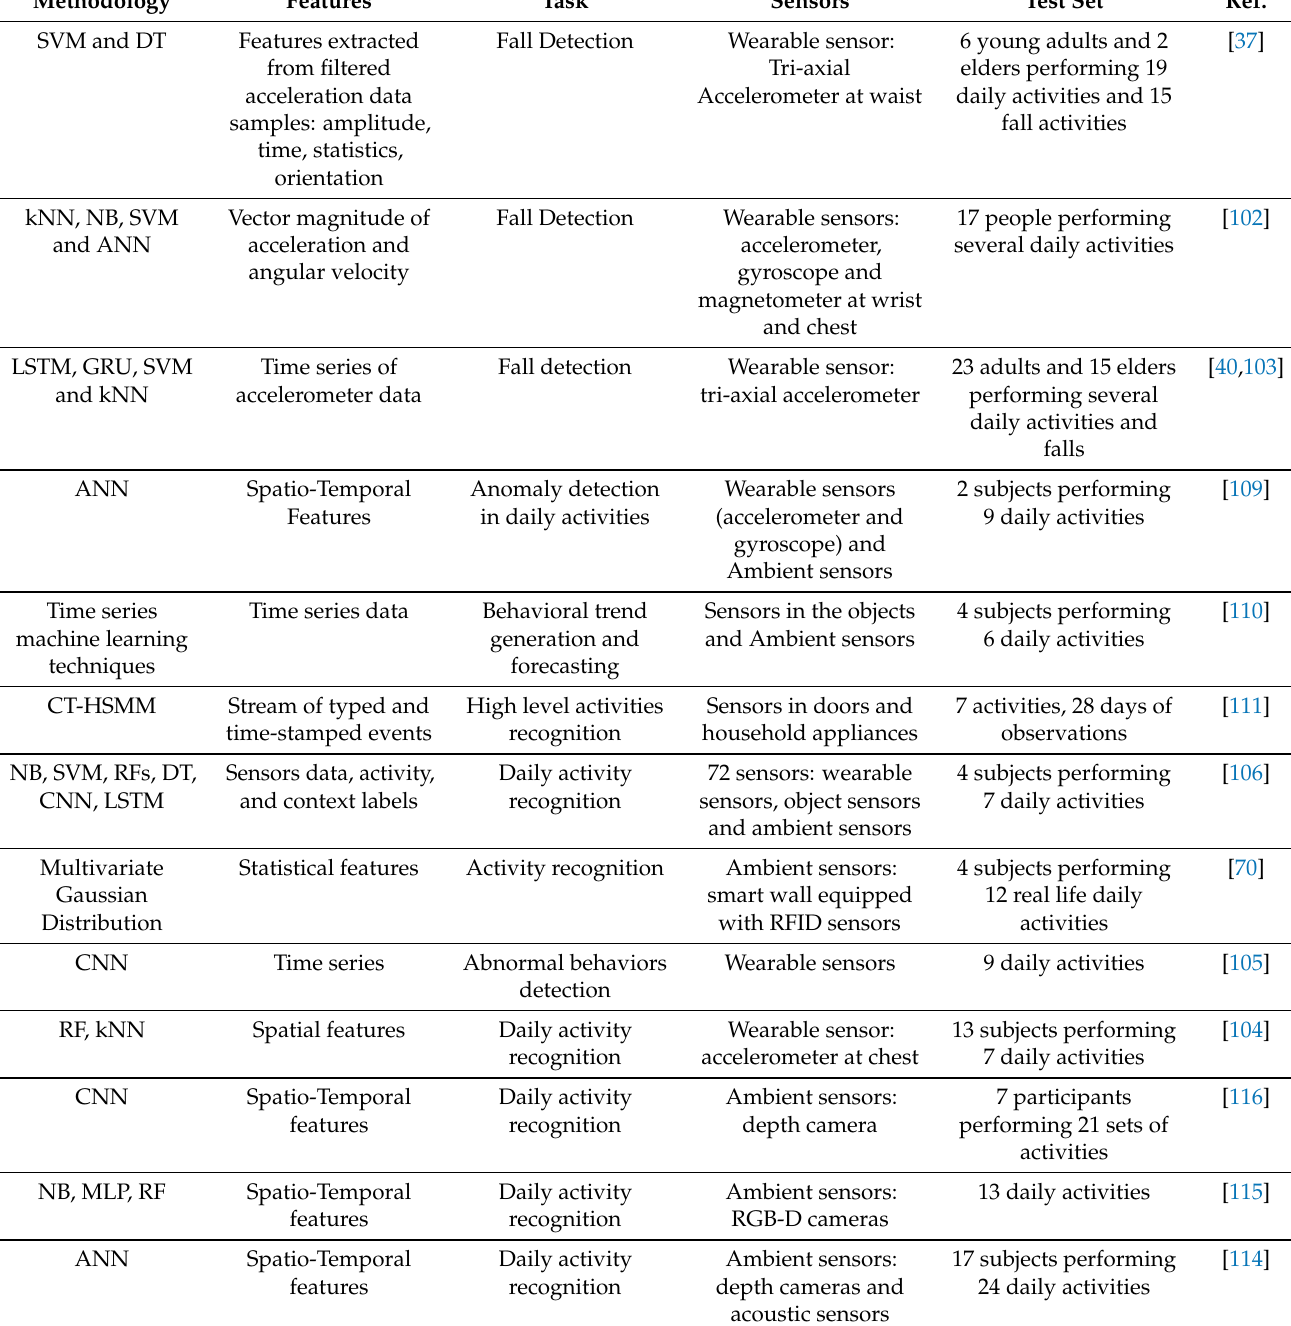
Table 2. A list of common methodologies for data